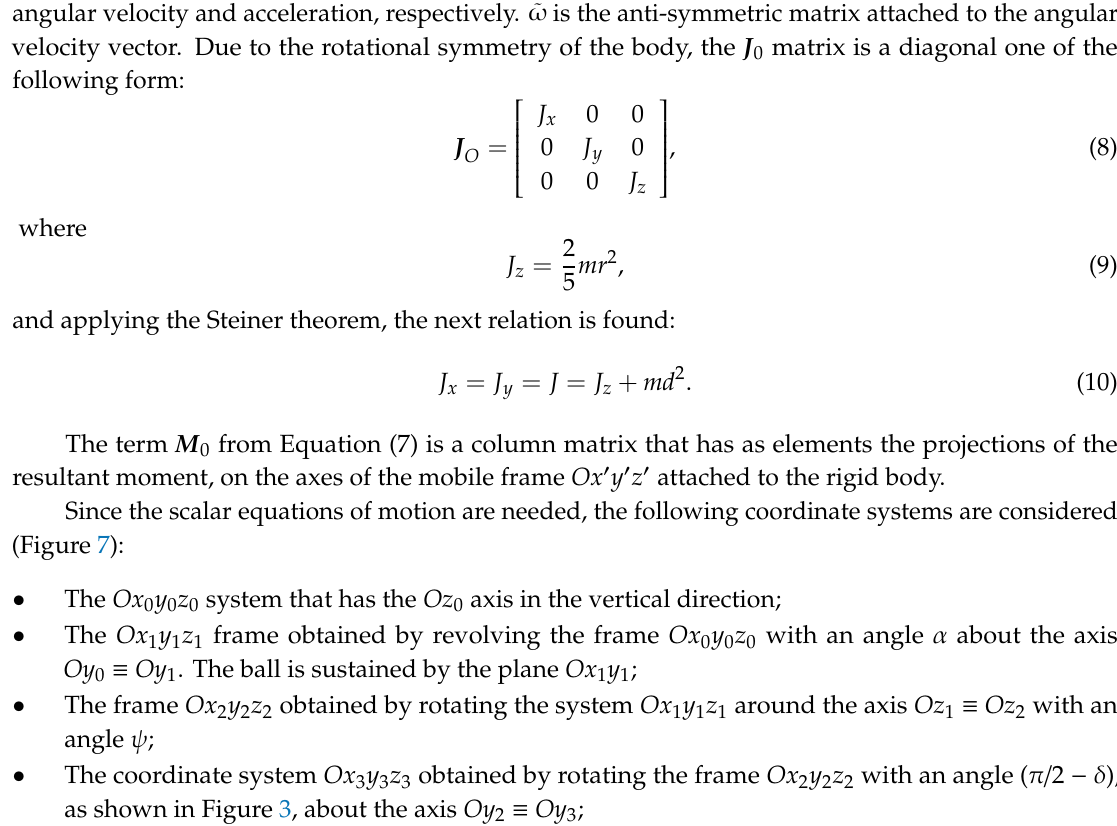
Figure 6. The reference systems used for the model.